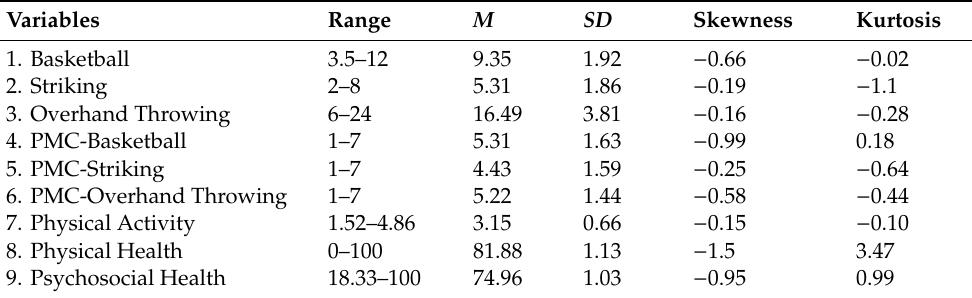
Table 2. Descriptive analysis for the study variables ( N =